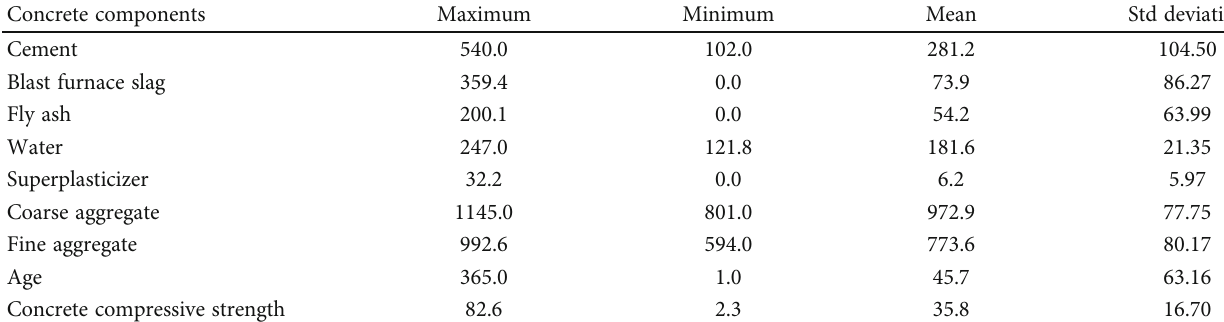
Table 5: Statistical features of concrete data sets.